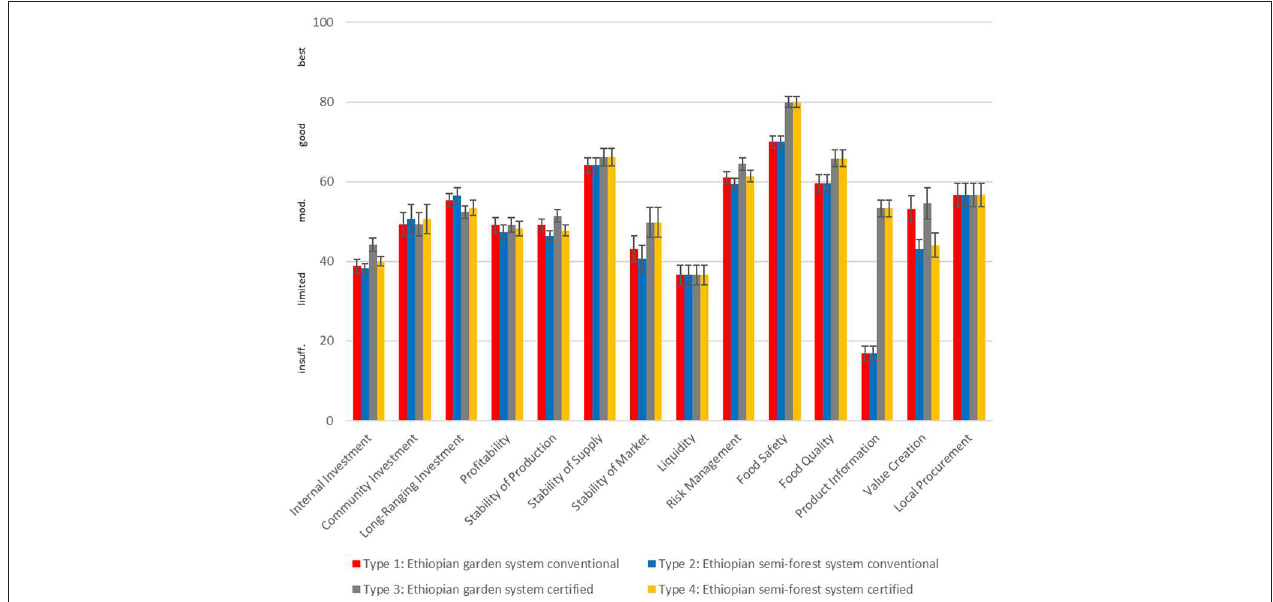
FIGURE 4 | Sustainability performance of typical Ethiopian coffee production systems in “Economic Resilience”.